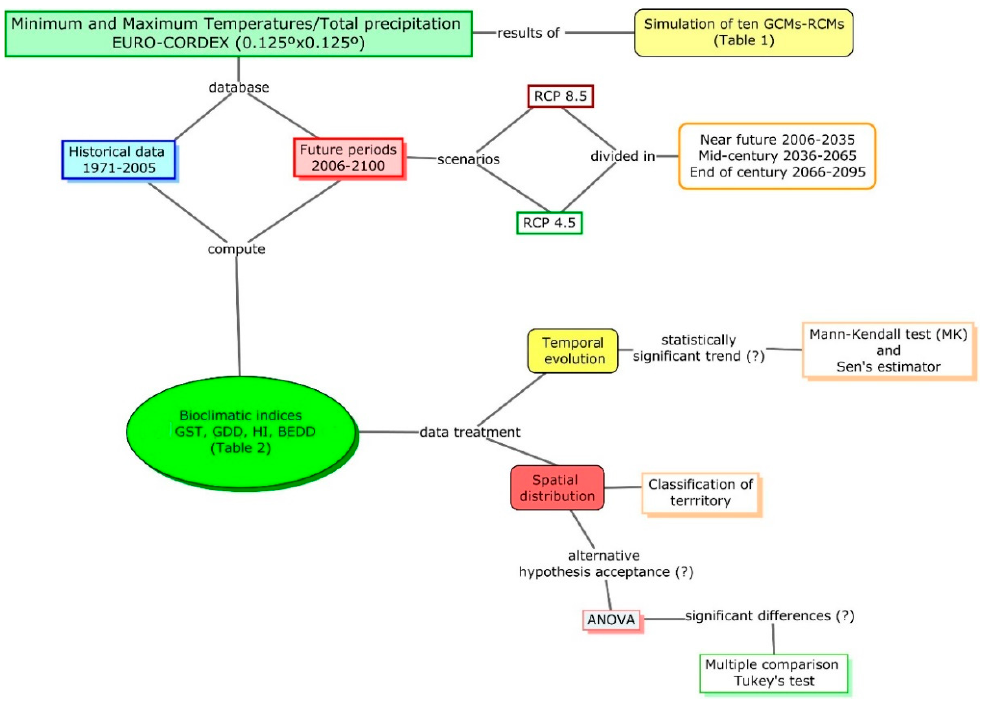
Figure 2. The overall methodological framework of this study.